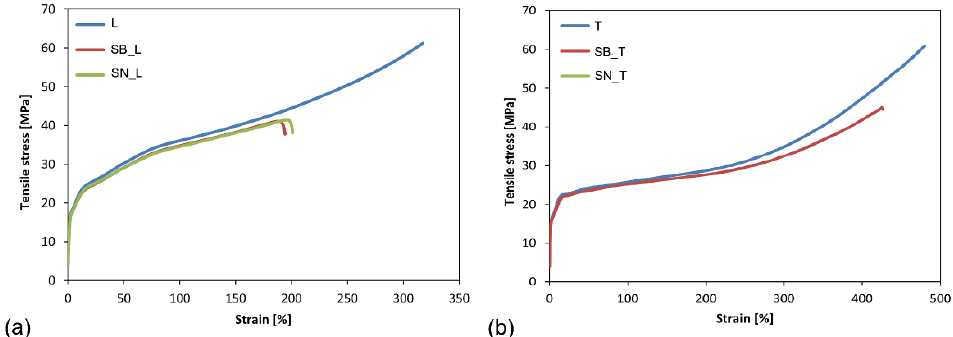
Figure 2. Comparison of the stress-strain curves before and after aging for L ( a ) and T ( b ) ETFE specimens on the white (SB) and black (SN) substrates. The SN_T curve is superimposed on the SB_T curve.